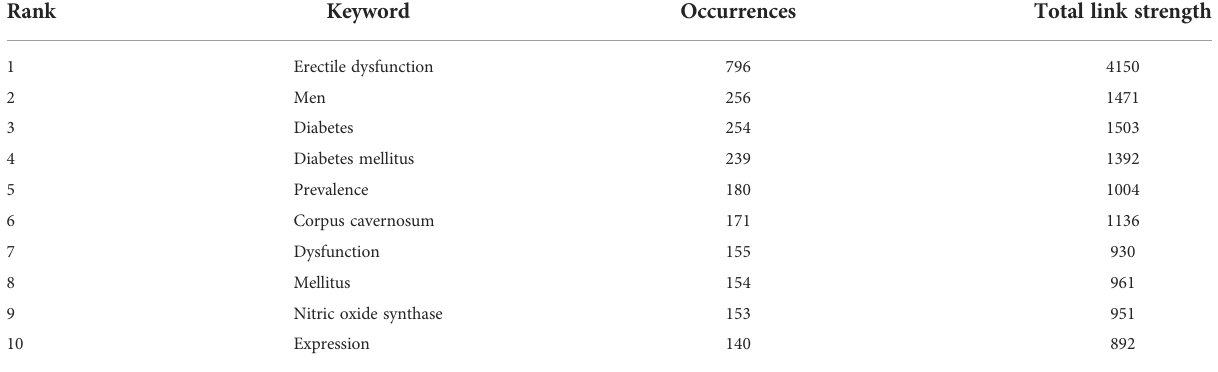
TABLE 10 Top 10 keywords related to the fi eld of assisted